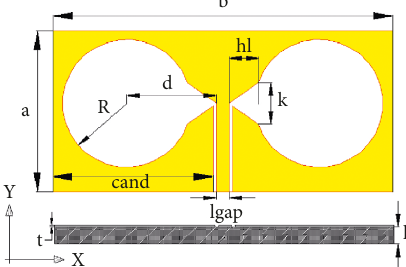
Figure 3: The geometry of antenna 2 with the water droplet slots.